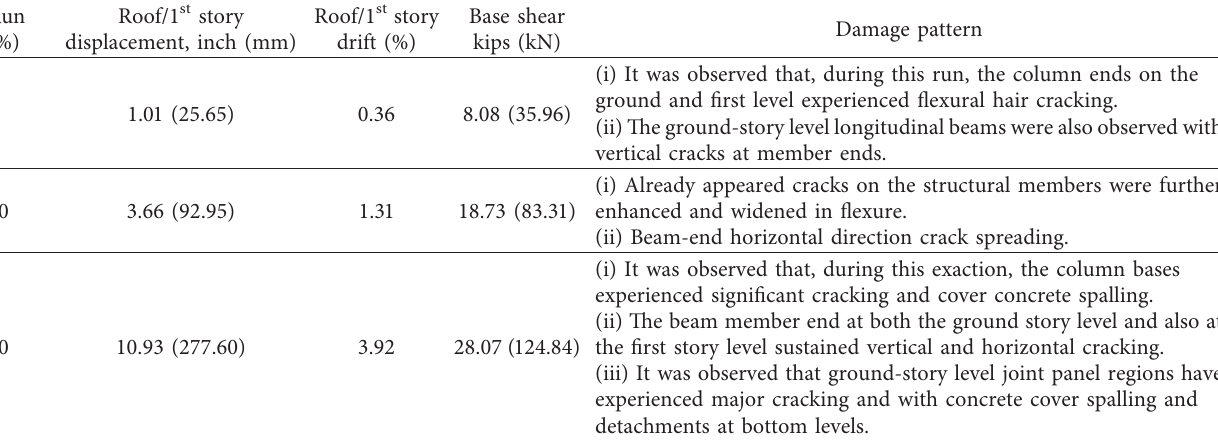
Table 3: Observed response and damage condition of Model-3 under significant runs.